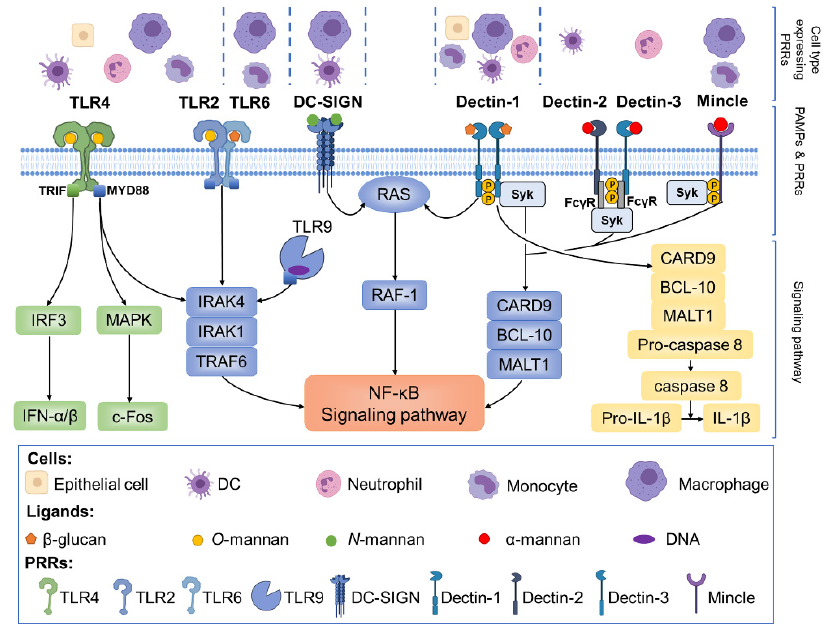
Figure 1. The main PRRs involved in immunity to Candida . Cell surface TLR2, TLR4, and TLR6 sense mannans and intracellular TLR9 sense DNA, and they all signal to IRAKs through MYD88. Then, the phosphorylation of IRAK4/IRAK1/TRAF6 activates the NF- κ B pathway. Dectin-1 and DC-SIGN also activate NF- κ B signaling via the RAS-RAF-1 pathway. Moreover, the dectin-1 homodimer, the dectin-2 and dectin-3 heterodimers, and Mincle recruit Syk in a Fc γ R-dependent manner to form a CARD9/BCL-10/MALT1 scaffold, which activates NF- κ B in a classical way. In addition, dectin-1 mediates the formation of the CARD9/BCL-10/MALT1 complex to promote IL-1 β secretion via the non-classical caspase-8 pathway. In response to TLR4, the MAPK/c-Fos pathway is also activated by MYD88, while the transcription of IFN- α / β is promoted by TRIF-mediated IRF3. PRRs, pattern recognition receptors; TLR, toll-like receptor; IRAKs, the interleukin-1 receptor-associated kinases; MYD88, myeloid differentiation primary response 88; IRAK4, interleukin-1 receptor-associated kinase 4; IRAK1, interleukin-1 receptor-associated kinase 1; TRAF6, tumor necrosis factor receptor- associated factor 6; NF- κ B, the nuclear factor-kappa B; DC-SIGN, dendritic cell-specific intercellular adhesion molecule-3-grabbing non-integrin; Mincle, macrophage-inducible C-type lectin; Fc γ R, Fc- gamma receptor; CARD9, caspase recruitment domain containing protein 9; BCL-10, B-cell lymphoma 10; IL, interleukin; MAPK, mitogen-activated protein kinases; IFN, interferons; TRIF, Toll/IL-1R domain-containing adaptor-inducing IFN-beta; IRF3, interferons regulatory factor 3. The main PAMPs of s Candida cell wall include β -glucan, simple linear chain O -man- nan, and N -mannan with multiple lateral α - or β -mannose branches. TLR2, TLR4, and TLR6 are cell membrane-associated, whereas TLR9 is located inside the cells [25]. TLR2 and TLR4 recognize O -mannan, TLR6 is involved in the recognition of β -glucan, and TLR9 detects fungal DNA [27,28]. The TLR2–TLR6 heterodimers, together with cell surface TLR4 dimers and intracellular TLR9 [29,30], are reported to signal to the interleukin (IL)- 1 receptor-associated kinases (IRAKs) through adaptor protein MYD88, thus forming a complex with IRAK4, IRAK1, and TNF receptor-associated factor 6 (TRAF6) [31,32]. nu- clear factor-kappa B (NF- κ B) can be activated by TRAF6-induced cascade signaling to in- itiate the transcription process of inflammatory cytokines (tumor necrosis factor (TNF), IL-1, and IL-6) and chemokines (IL-8, CXCL1, CCL3, and CXCL2) [33]. In addition, an- other signaling pathway induced by TLRs also plays a role in the antifungal response. The mitogen-activated protein kinase (MAPK) signaling pathway can be activated by TLR4, increasing c-Fos expression [34], contributing to the clearance of infected cells [35,36]. TLR4 also activates the IFNG gene via IFN regulatory factor 3 (IRF3) [37,38]. As another type of PRR, CLRs include dectin-1, dectin-2, dectin-3 [39], macrophage-inducible C-type